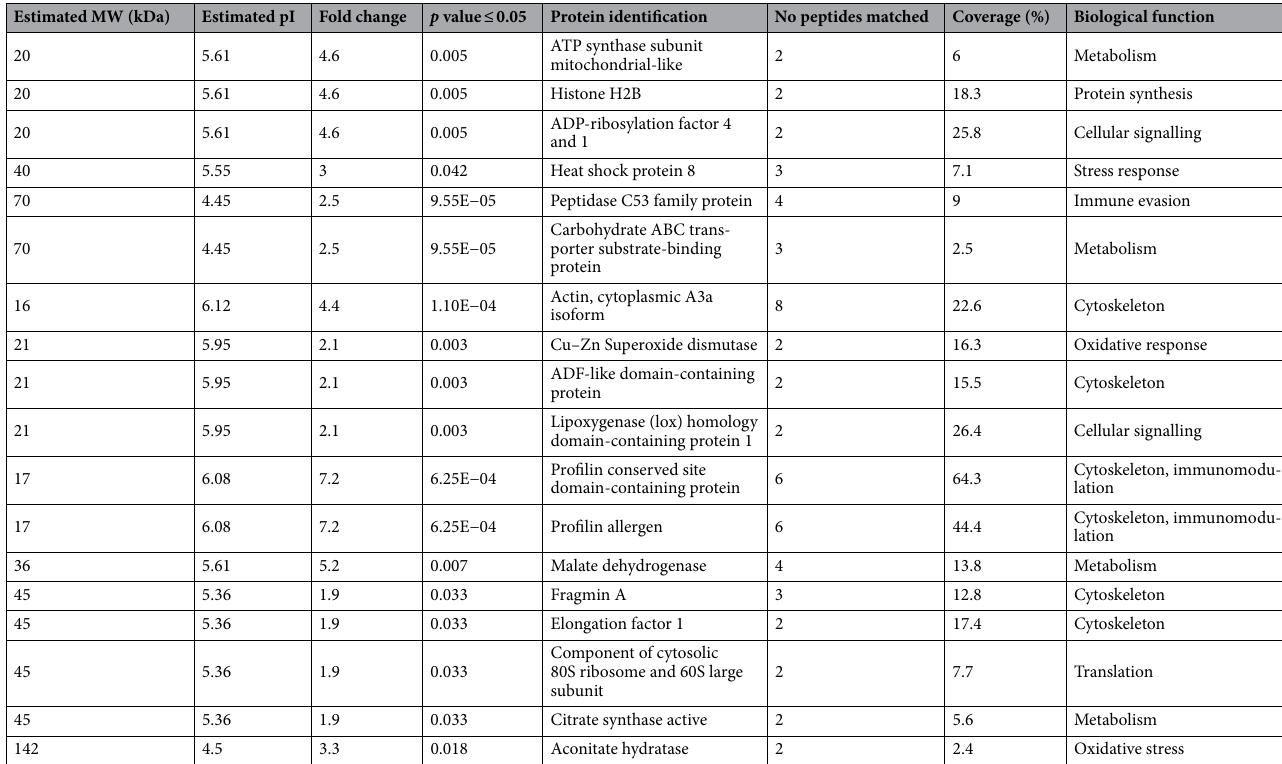
Table 1. 2D spots with significant ( p ≤ 0.05) fold changes from the newly acquired N. perurans culture identified by LC–MS/MS from N. perurans . The complete list of proteins identified from the large collated Amoebozoa database are distinguished in the organism header of Supplementary Table S2. N. perurans GenBank IDs can be found in Supplementary Table